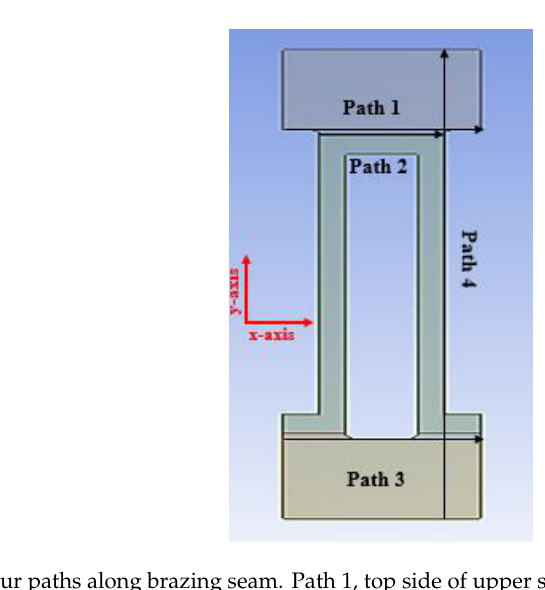
Figure 3. Four paths along brazing seam. Path 1, top side of upper seam. Path 2, bottom side of upper seam. Path 3, lower side of bottom seam. Path 4, vertical path passing through both seams.